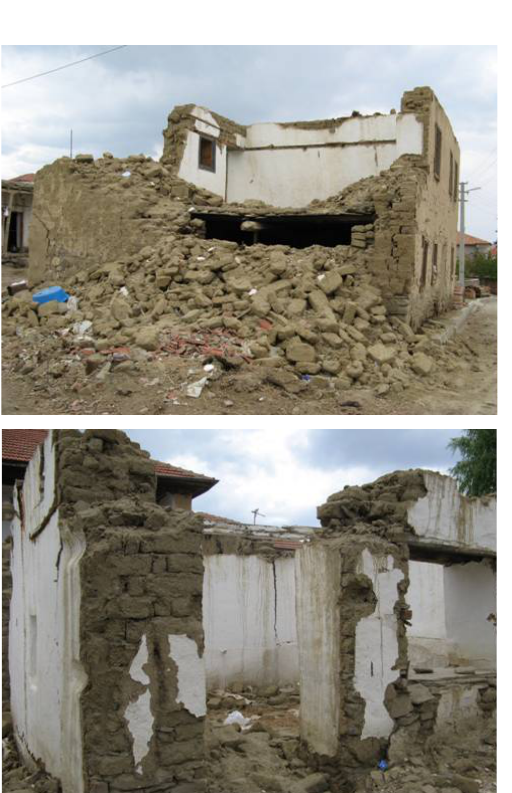
Fig. 6 Response spectrums of Bala (Ankara) Earthquake on December 20, 2007.